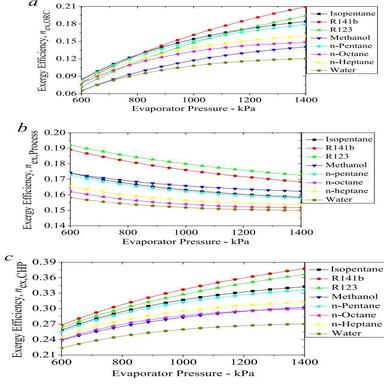
Effect of evaporator pressure on exergy efficiencies in ORC (a) Process (b) CHP (c).